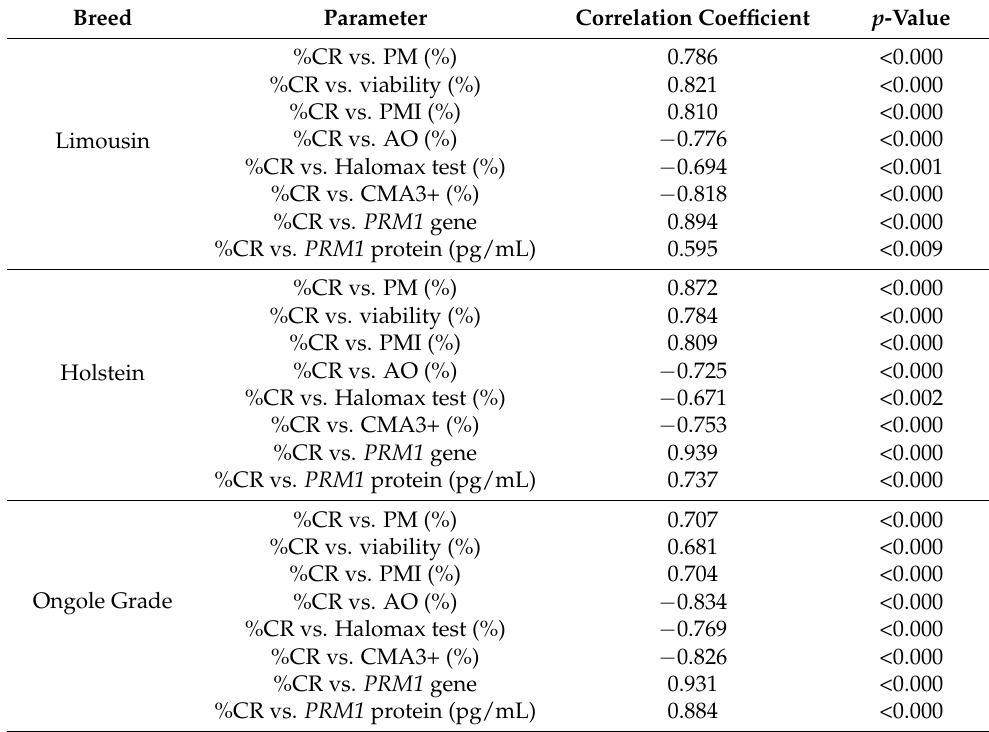
Table 2. Correlation of bull fertility scores with sperm quality parameters, SDF, PRM1 gene, and protein abundance in Limousin, Holstein, and Ongole Grade bulls a .